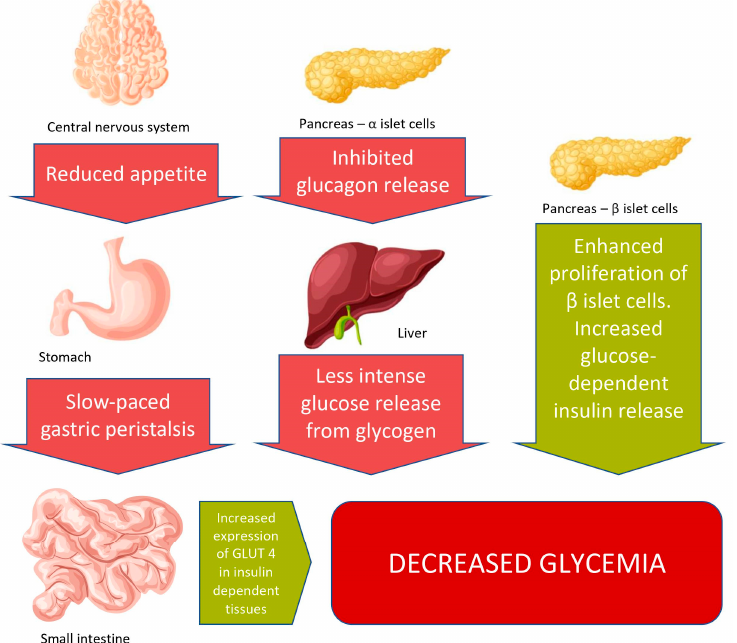
Figure 1. Effects of GLP-1RAs on organs and tissues. The drugs increase glucose-dependent insulin release by acting on pancreatic islets β cells and inhibit glucagon release by acting on pancreatic islets α cells. It leads to decreased glucose release from liver glycogen to circulation. They also enhance the proliferation of β cells. By acting on the central nervous system, GLP-1RAs reduce appetite, which along with slower gastric emptying, leads to reduced food intake. All these effects contribute to a reduction in blood glucose levels. Pictures used to create this figure is designed by macrovector Freepik.